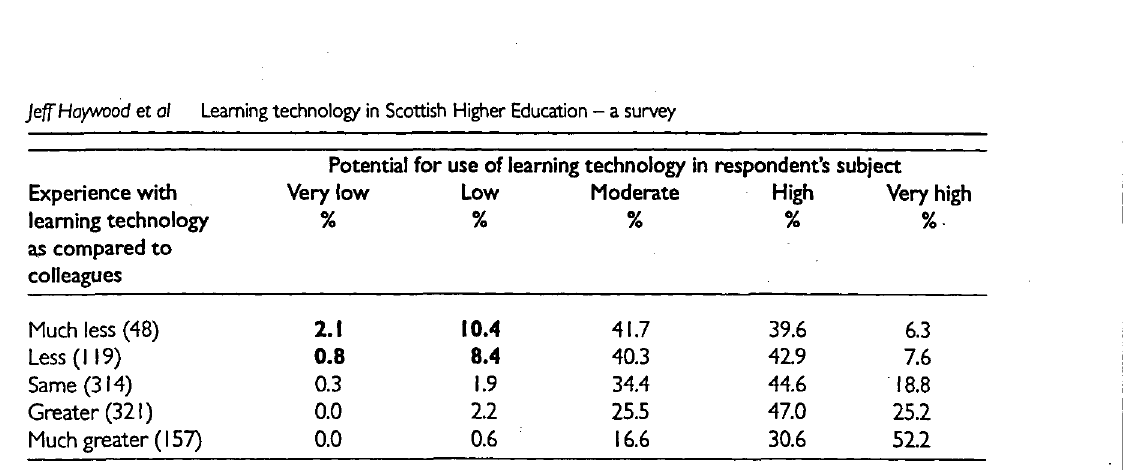
Table I: Respondents'ratings of the potential of learning technology in their subject area versus their self-rating of their experience with the use of learning technology in comparison to their colleagues. Total numbers of respondents in each self-rating category are shown in parentheses in Column I. The bold entries highlight the small numbers of staff with little experience of learning technology who